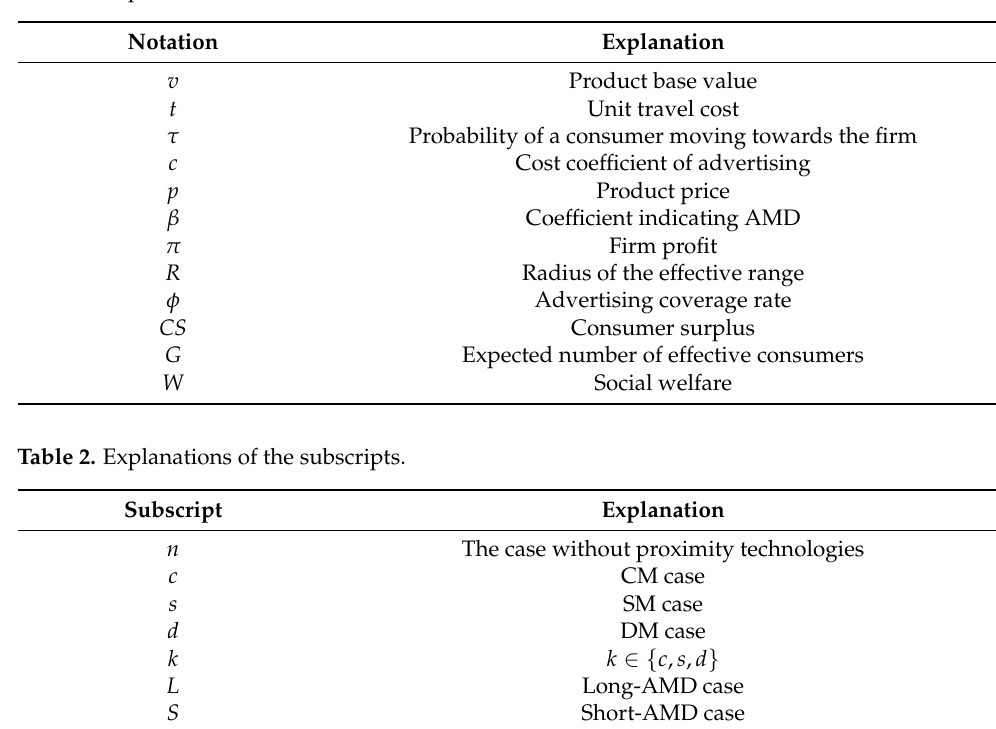
Table 1. Explanations of the notations.